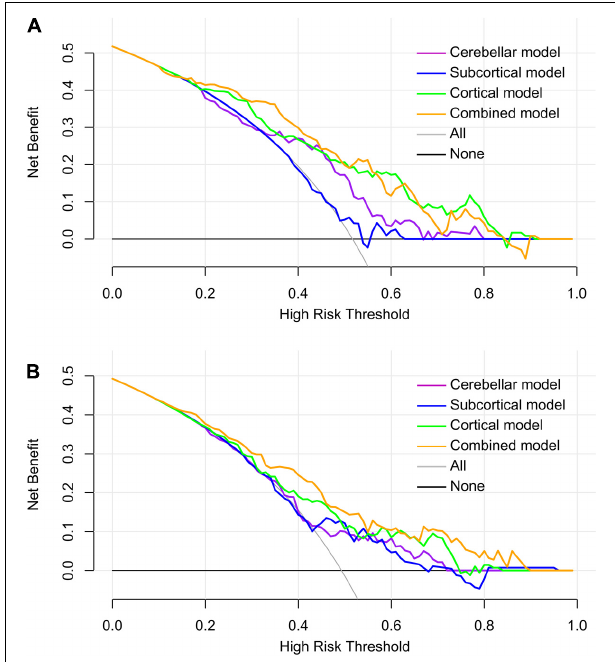
FIGURE 5 | Decision curve analysis of the predictive models in the internal validation dataset (A) and the independent test dataset (B) . Within a larger threshold probability range, the combined model has the highest clinical net benefit, followed by the cortical